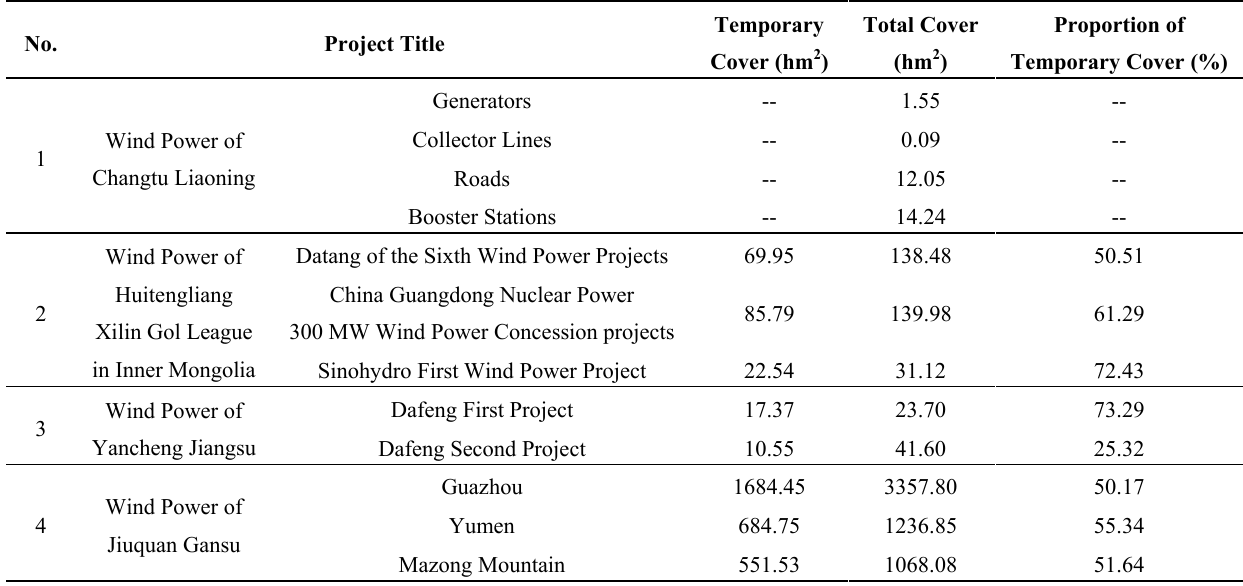
Table 1. Land Area Occupied during Wind Power